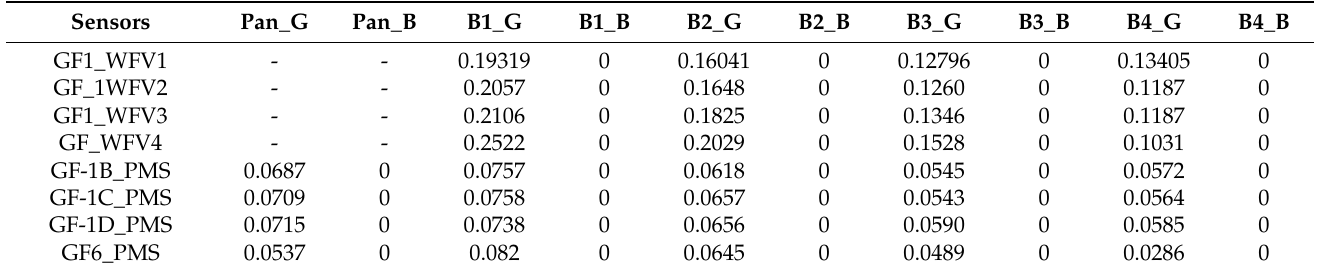
Table 4. Radiometric calibration parameters of the GF